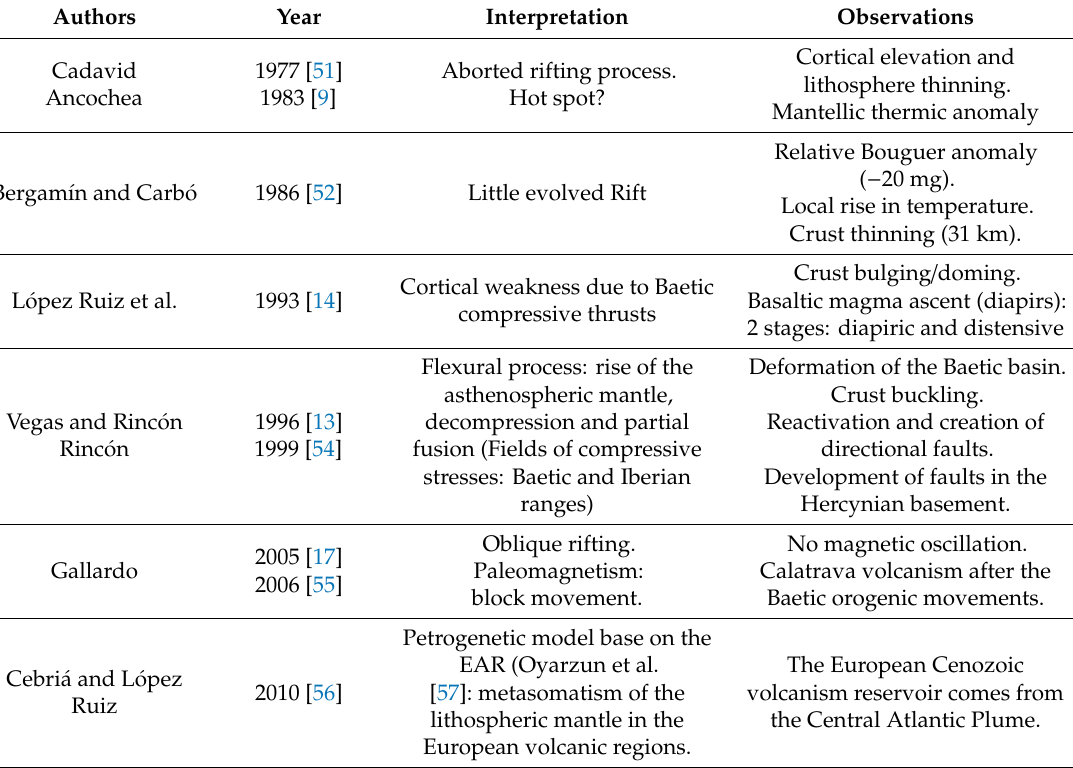
Table 1. Di ff erent hypotheses on the genesis of the Campo de Calatrava Volcanic Region.